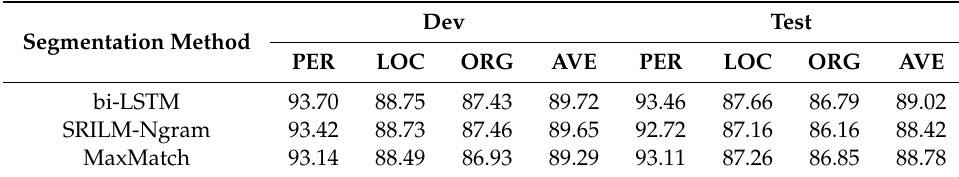
Table 3. Comparison of morphological segmentation on subword-based neural models (%).